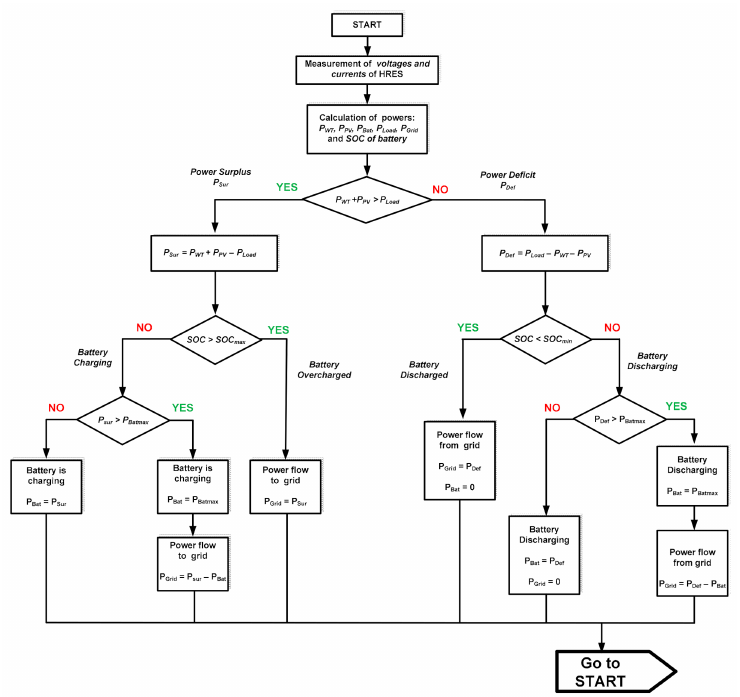
Figure 15. The flowchart of Energy Management Strategy (EMS) for grid-connected